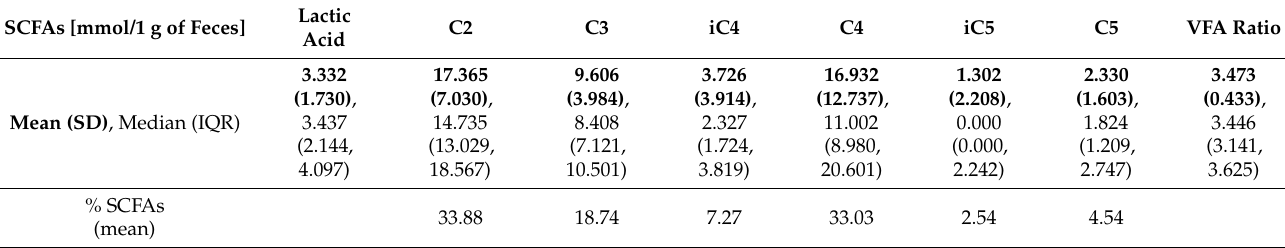
Table 3. The results of short-chain fatty acid analysis.